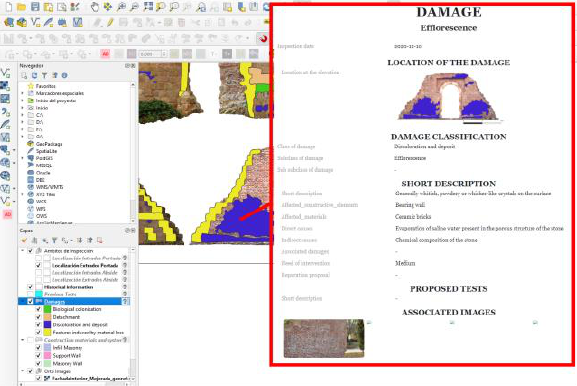
Figure 11. Access to the HTML file created for the efflorescences at the intrados of the